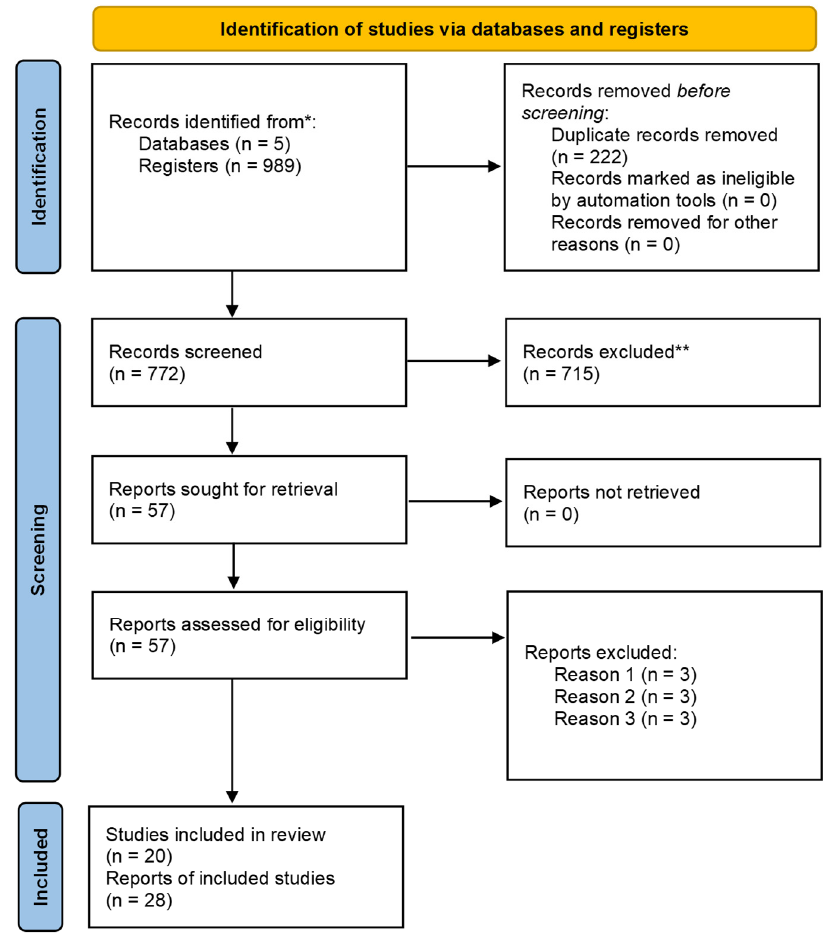
Figure 2. The PRISMA flowchart of the study selection [13]. Table 1. The list of abbreviations used in this review.